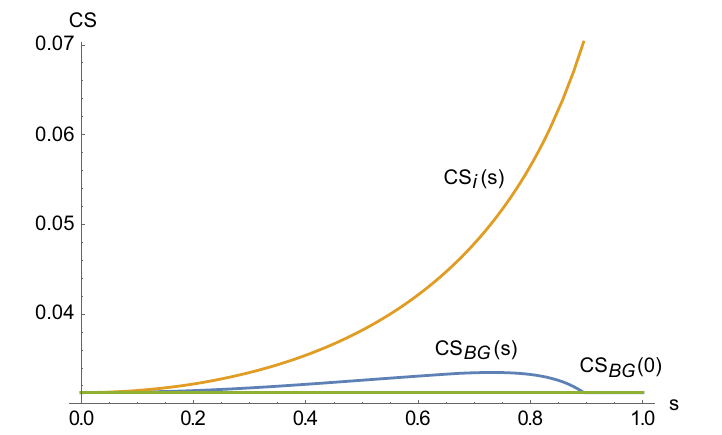
Fig. 4 Consumer surplus for buyer group members, CS BG ( s ), and non-members, CS i ( s ), as a function of the buyer group size, when there is no a KAM program. Parameter values: z (cid:4) 1.4